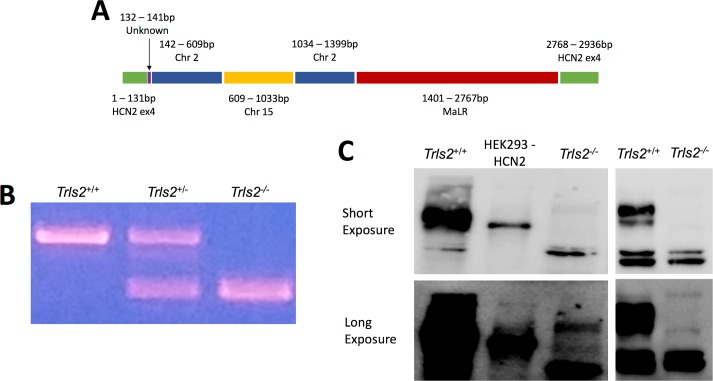
Insertion in exon 4 of Hcn2 causes loss of protein in TRLS/2J mice.A) Sanger sequencing revealed a ~2.5kb insertion into exon 4 of HCN2. This mutation started with an unknown, 9bp sequence followed by genomic DNA from Chromosome (Chr) 2, genomic DNA from Chr 15, another distinct genomic sequence from Chr 2, and then a large Mammalian apparent LTR Retrotransposon (MaLR) sequence. B) Primers were made to genotype TRLS/2J mice based on the mutation sequence and could detect the wildtype allele (473bp) and the TRLS/2J allele (289bp). An example of this genotyping is shown from Trls2+/+, Trls2+/-, and Trls2-/- mice. C) N-terminal (left panels) and C-terminal (right panel) antibodies against HCN2 revealed complete loss of protein in Trls2-/- mice. The upper panels were taken with a short exposure while the lower panels were taken with a longer exposure to confirm that no protein band was present. Two non-specific bands are located in both Trls2+/+ and Trls2-/- mice.